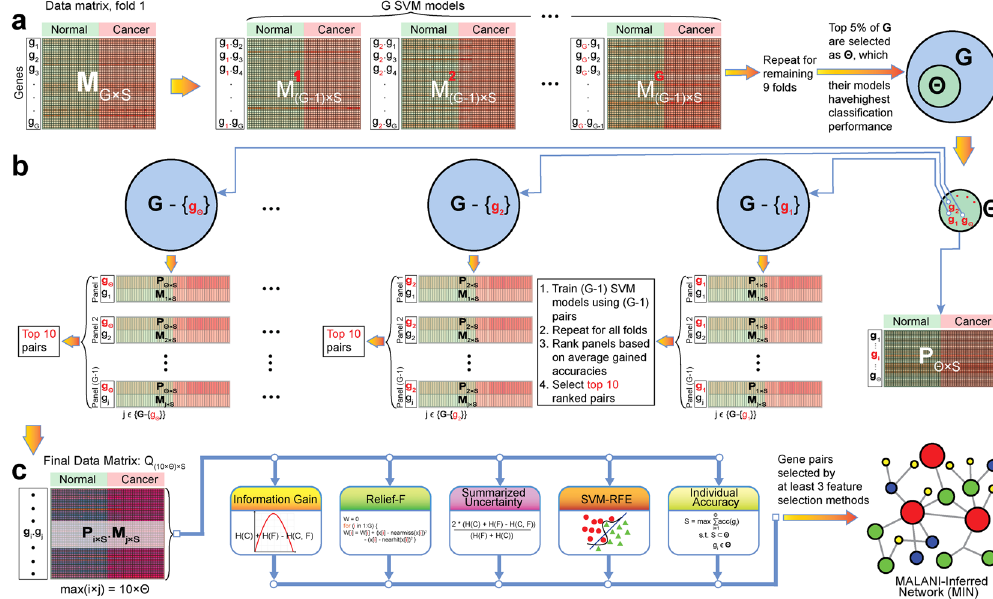
Figure 1. Overview of Machine Learning-Assisted Network Inference (MALANI) algorithm to infer a cancer network for a given cancer type. The overall MALANI procedure consists of three major stages: ( a ) Stage 1: Construction of gene-wise models. Step 1.1: Split gene expression data matrix for 10-fold cross-validation. Original gene expression matrix is represented as M G × S where G represents the number of genes (rows in data matrix) and S represents samples (column in data matrix). The gene expression matrix was split into 10 portions, each for cancer and normal samples. Step 1.2: Construct gene-wise dot product matrices. For the first training fold, gene-wise dot product matrices are constructed from split data from step 1.1. Step 1.3: Model training and testing. Gene-wise matrices generated from Step 1.2 were used for training and the remaining one split portion as testing. The step was then repeated 9 times for 10-fold cross-validation (see Materials and Methods for more detailed description). Step 1.4: Evaluation of gene-wise model performance. Performance of gene-wise dot product models were assessed for their capability to classify cancer vs. normal samples. The top 5% gene-wise models with the best classification performance that constitute a gene set of Θ were selected. ( b ) Stage 2: Construction of gene-pair models. Step 2.1: Construction of gene-pair vector from Θ set. Using data from Step 1.1, vectors of gene pairs from a set of Θ genes obtained from Step 1.4 (denoted as red “g”) with remaining genes in the expression array (denoted as black “g”) were constructed. Step 2.2: Model training and testing. Each vector corresponding to a gene in set Θ were used to train SVM models for each training fold and 10-fold cross-validation procedure as described in Step 1.3 was performed. Step 2.3: Evaluation of gene- pair model performances. Gene-pair model performance was assessed based on model’s capability to classify cancer vs. normal samples. Genes not found in the Θ set (black “g”) that paired with genes in the Θ set (red “g”) and were among the top 10 in terms of best classification performance were deemed functionally associated with a given gene in set Θ . ( c ) Stage 3: Inferring cancer networks. Step 3.1: Construction of finalized gene- pair dot product matrix. Step 3.2: Assessment of gene pair performance in classifying cancer samples. Five feature selection methods were used to assess performance of each gene pair dot product in classifying cancer vs. normal samples. Step 3.3: Construction of MALANI-Inferred Network (MIN) for a cancer. Selected gene pairs by at least three different feature selection methods in Step 3.2 were then agglomerated to reconstruct an inferred cancer